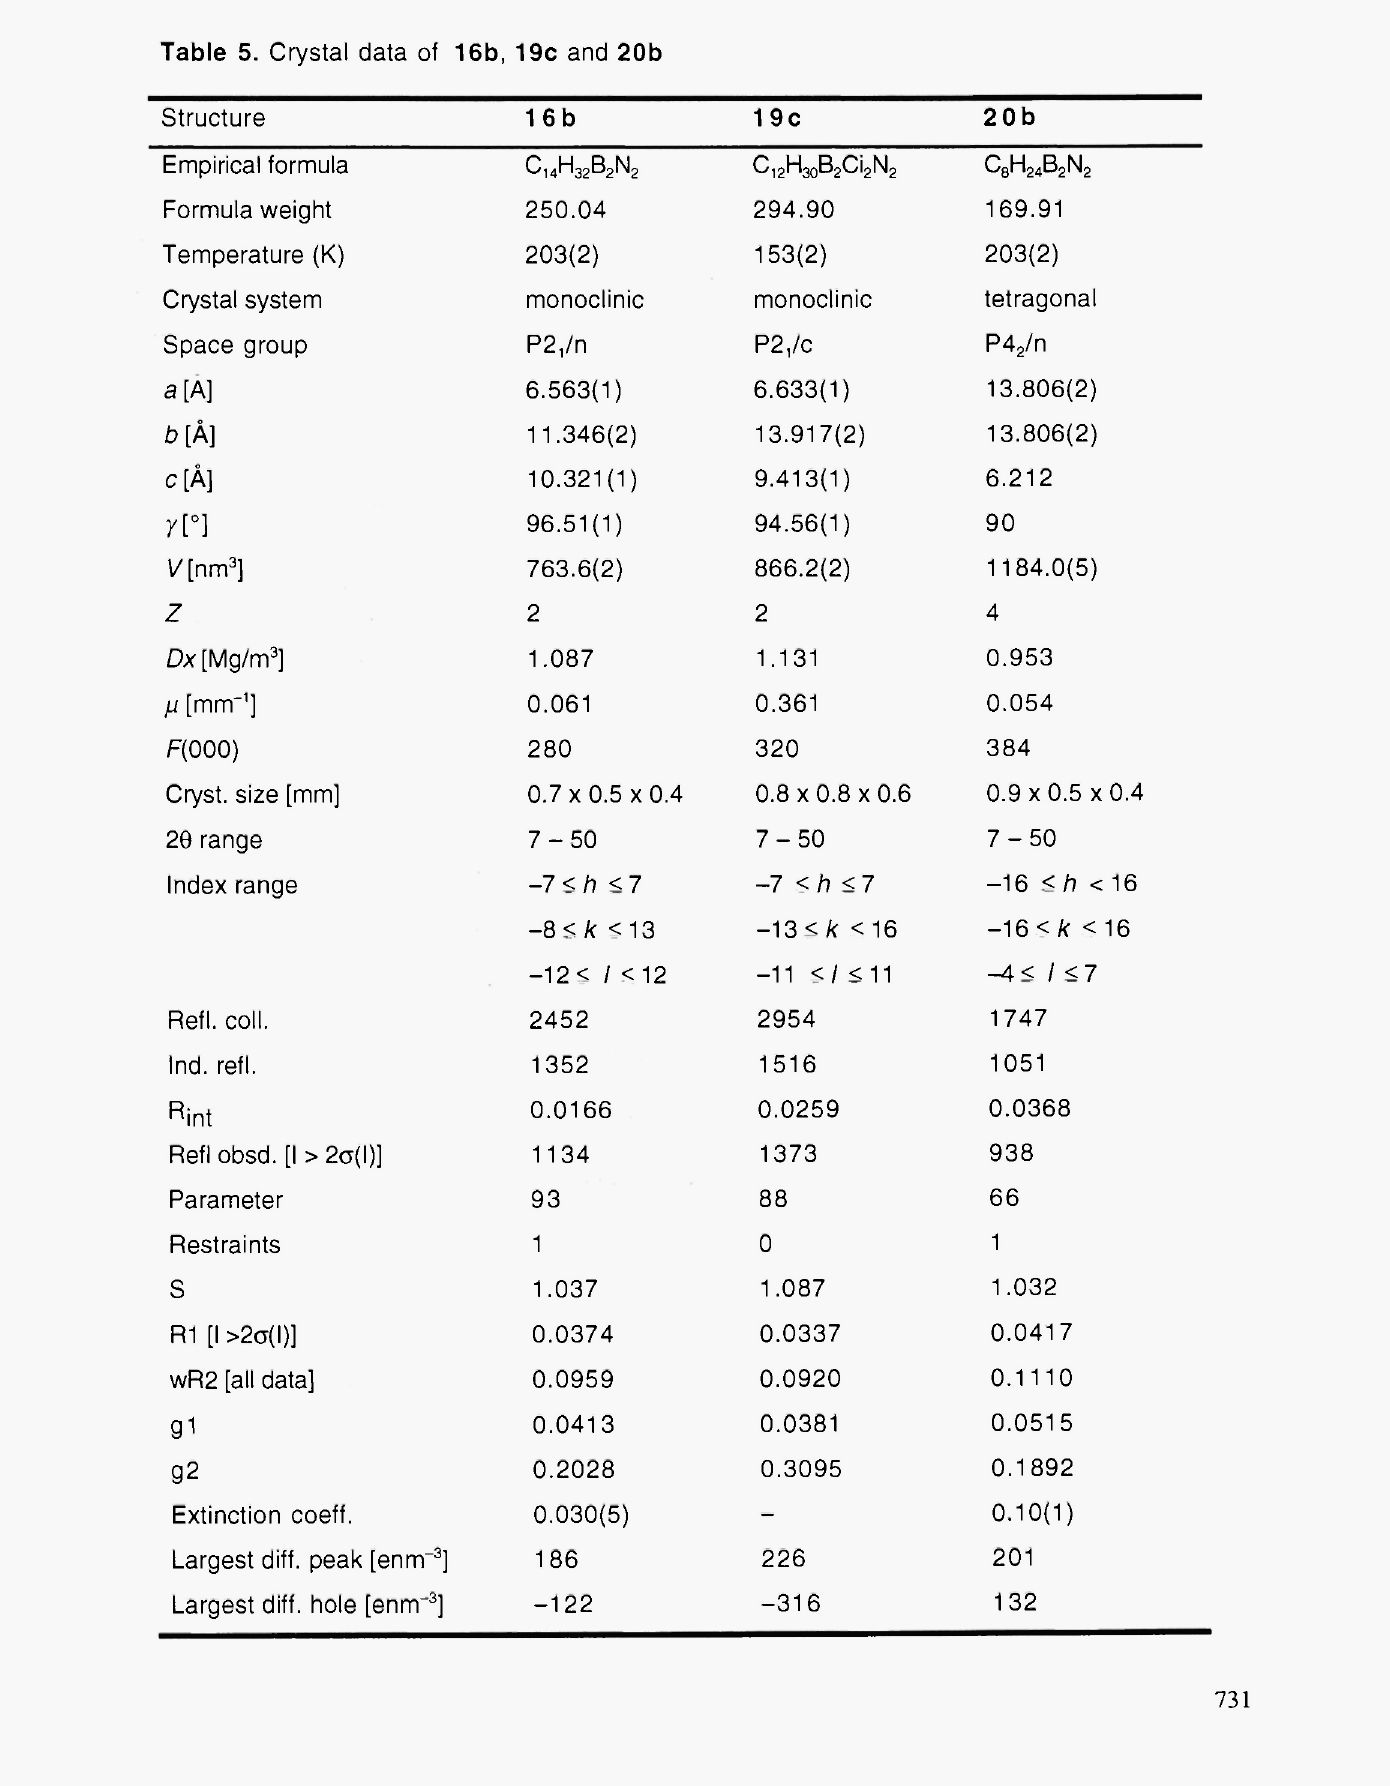
Table 5. Crystal data of 16b, 19c and